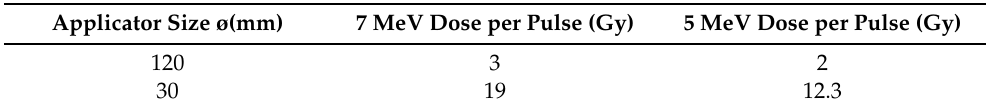
Table 2. Dose per pulse measurements with film (uncertainty of 5%), obtained with different applica- tors for a 4 pulse duration of µ s at energies at 5 MeV and 7 MeV.